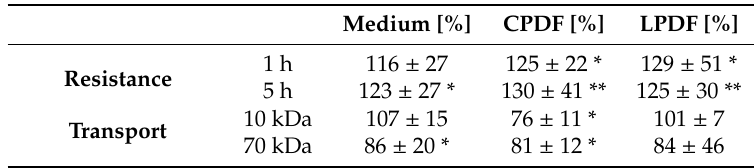
Table 1. Resistance and 10 kDa and 70 kDa transport across human primary endothelial cells (HUVEC) with 8 mM AlaGln added to medium and peritoneal dialysis (PD) fluids and expressed relative to respective AlaGln-free controls.